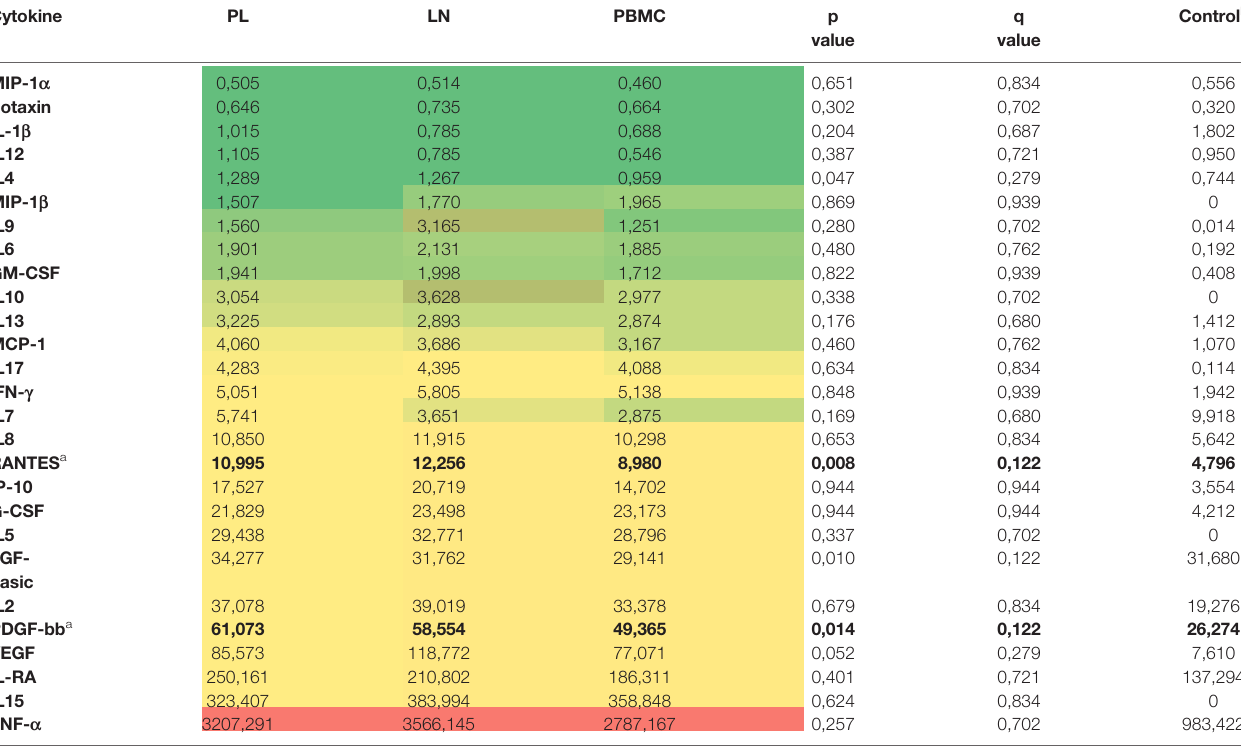
q Control b value value